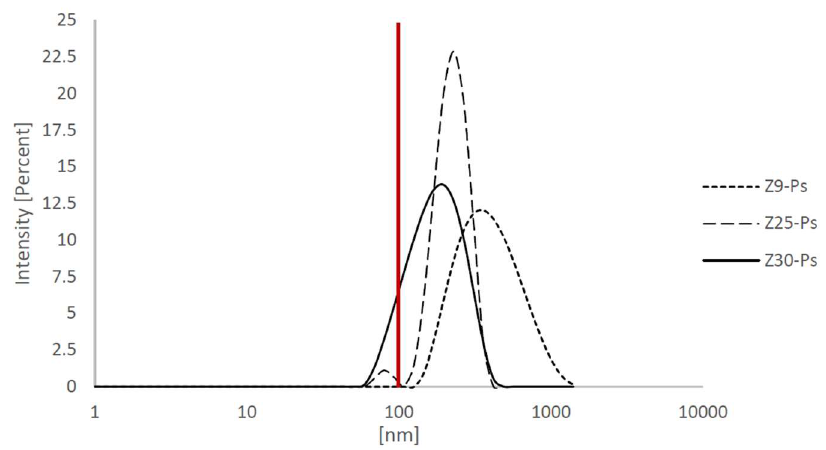
Figure 9. Normal distribution of particle size. The proportions of Z30-Ps ’ and Z25-Ps ’ nanometric particles can explain the higher photocatalytic activity of these species.